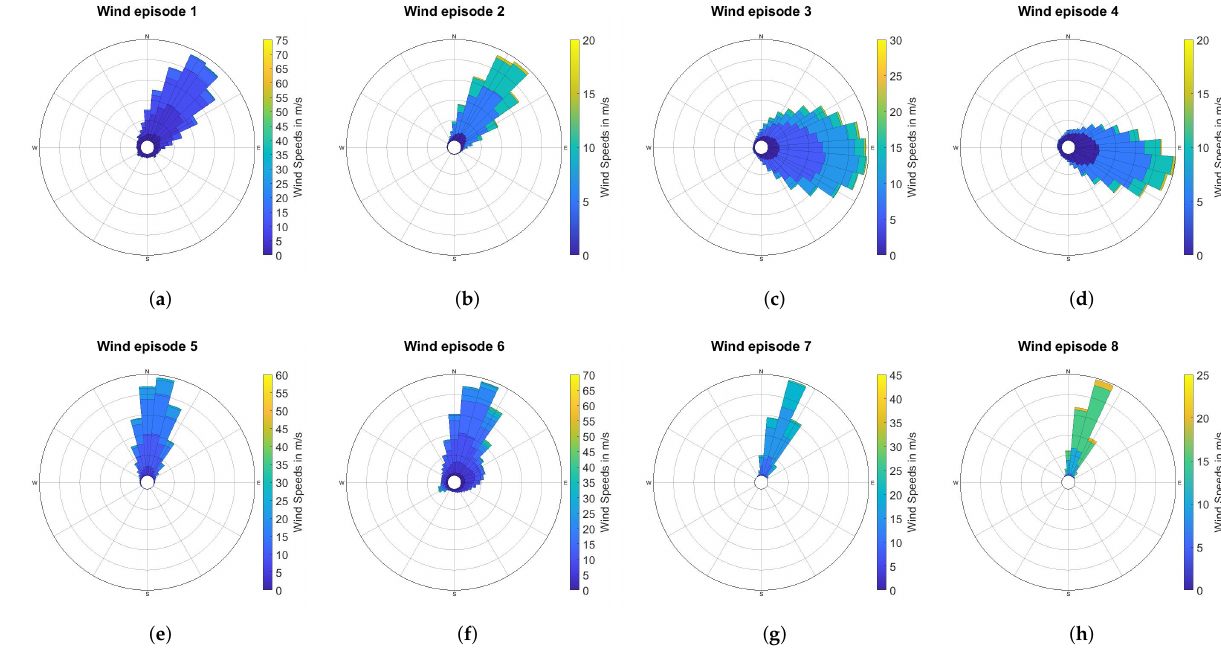
Figure A1. Cumulative wind speed and direction distribution for the heights between 80 and 180m at measurement site in Ajdovšˇcina during eight Bora episodes in November and December